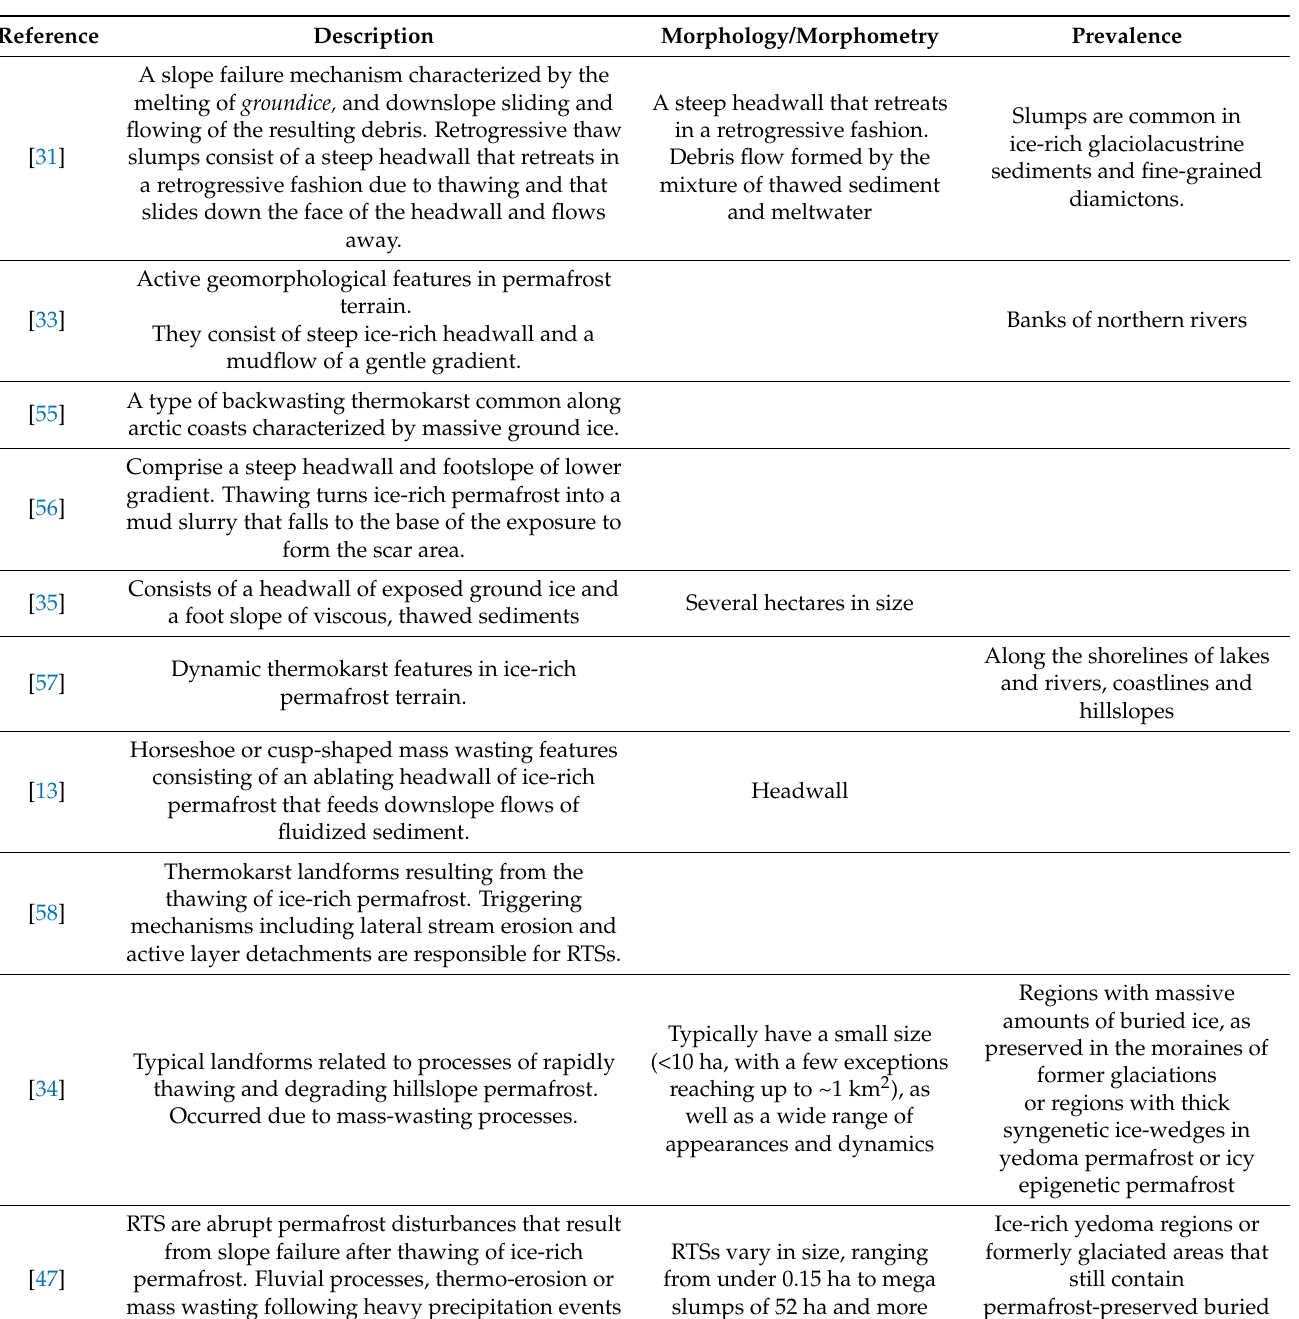
Table 1. Definitions, morphometric/morphological characteristics, and prevalence of retrogressive thaw